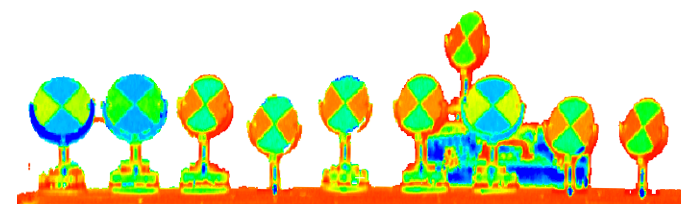
Figure 5. Exemplary point cloud of the ten scanned Leica Tilt&Turn-Target for the investigation of the algorithms’